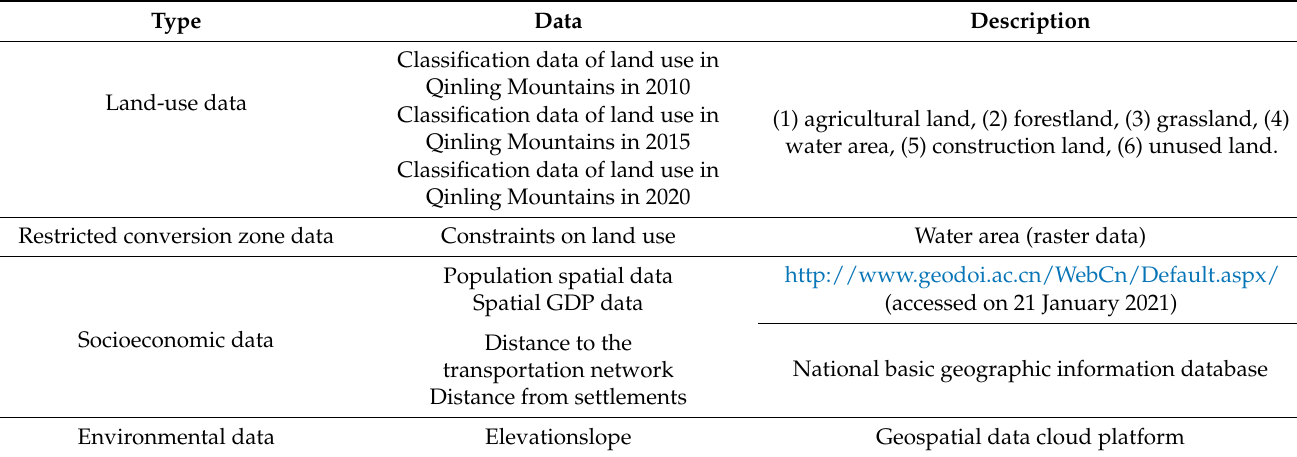
Figure 3. Spatial data required for SWAT Model construction in Shaanxi Weihe River basin. Table 3. PLUS model data